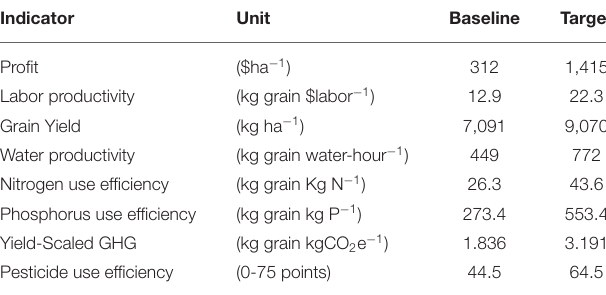
TABLE 2 | Baseline (population mean) and target (mean of top 20% performers: each category) values of performance indicators for 65 farms in Ferreñafe, Peru. Indicator Unit Baseline